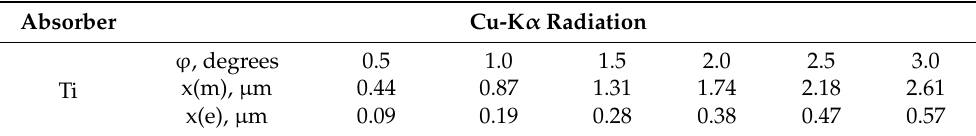
Table 1. Dependence of the penetration depth on the absorption of Cu–K α radiation in the titanium sample under grazing irradiation of the sample surface (Grazing Incidence Attachment).